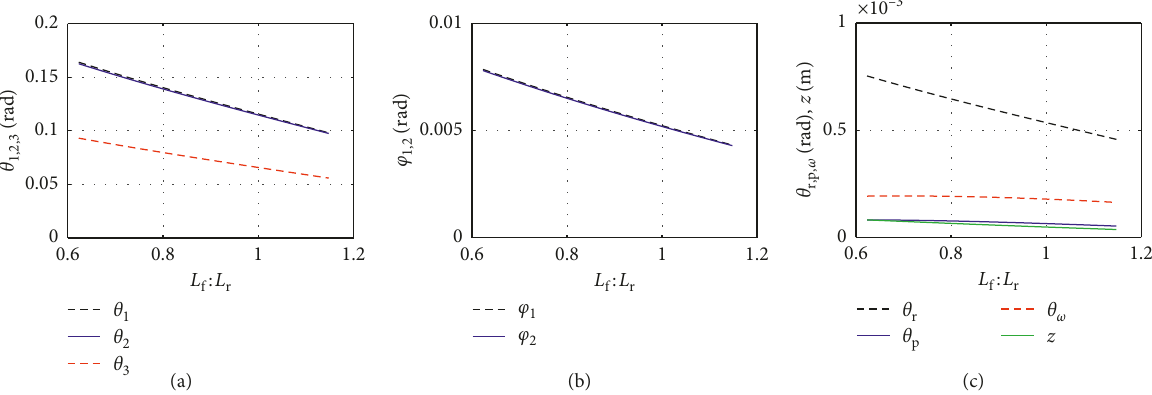
Figure 9: Influences of L f : L r on the amplitude of each DoF. (a) The amplitudes of θ 1,2,3 . (b) The amplitudes of φ 1,2 . (c) The amplitudes of θ r,p, ω , and z